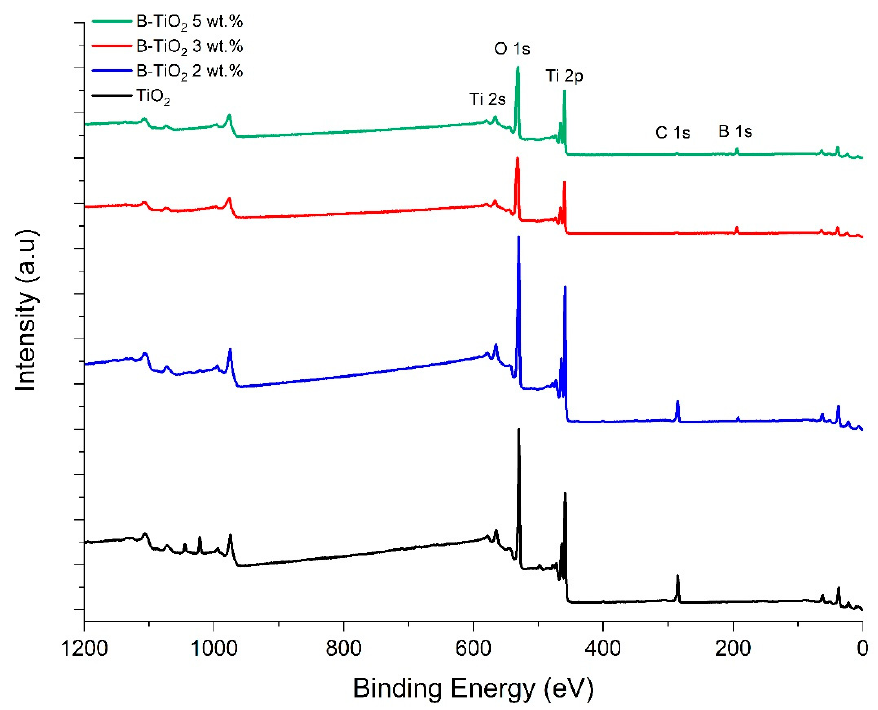
Figure 4. XPS survey spectra for the undoped and B-doped TiO 2 catalysts.